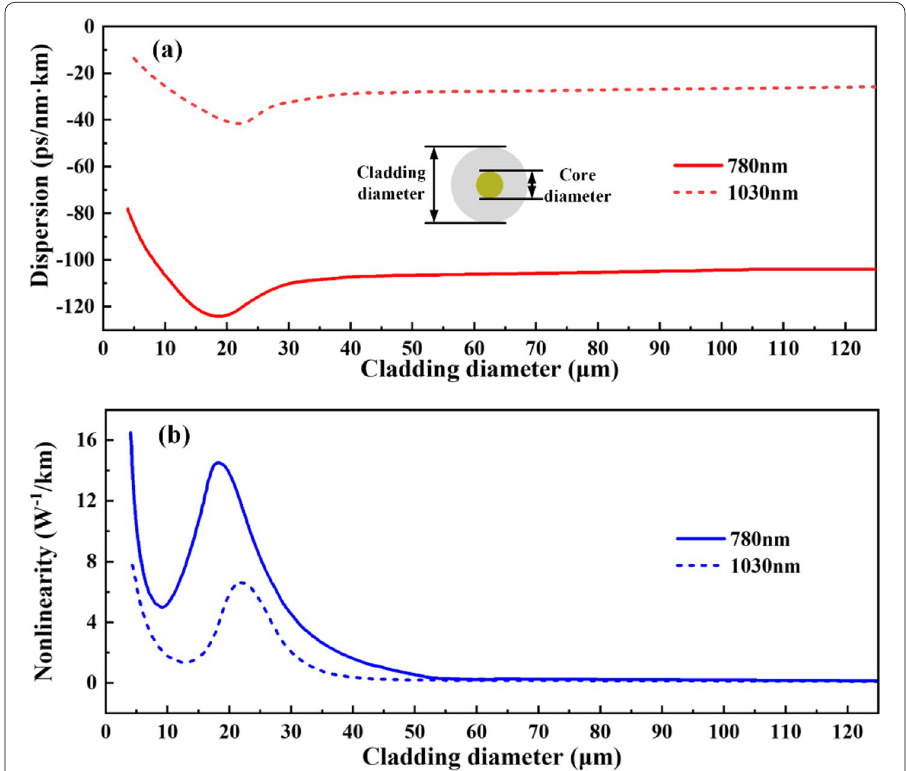
Fig.5 a Calculated dispersion of optical fiber with 4 µm ~ 125 µm cladding diameter. The dispersion at 780 nm and 1030 nm reaches minimum values of -124.04 ps/nm 21 μm cladding diameters, respectively. b Calculated nonlinearity of optical fiber with 4 µm ~ 125 µm cladding diameter. The nonlinearity at 780 nm and 1030 nm reaches maximum values of 14.52 W − 1 /km and 6.66 W − 1 /km at 19 μm and 22 μm cladding diameters respectively, and reaches minimum values of 4.98 W − 1 / km and 1.38 W − 1 /km at 9 μm and 12 μm cladding diameters